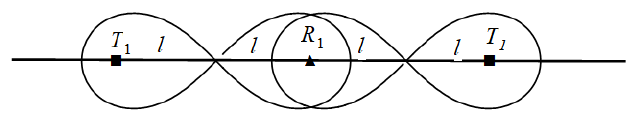
Figure A3. Maximum placement intervals of homogeneous BR sequence T 1 − R n − T 1 when n = 1.